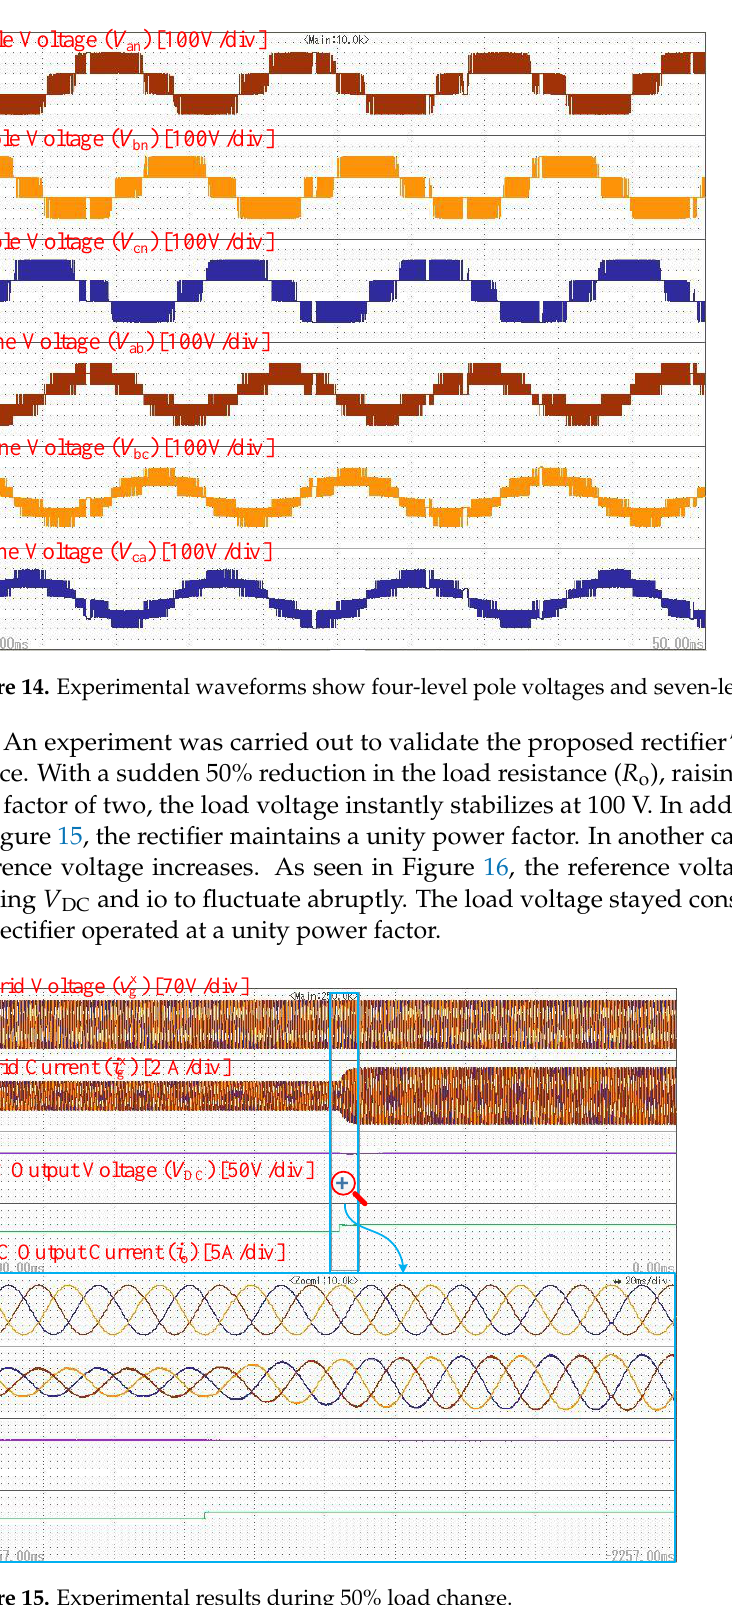
Figure 13. Steady-state experimental waveforms in the boost mode operation of the proposed recti- fier.